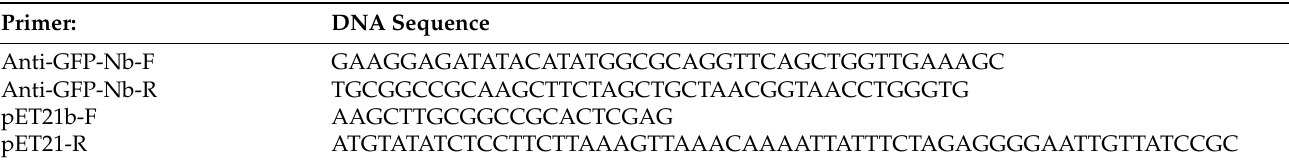
Table 1. Primer design for anti-GFP nanobody